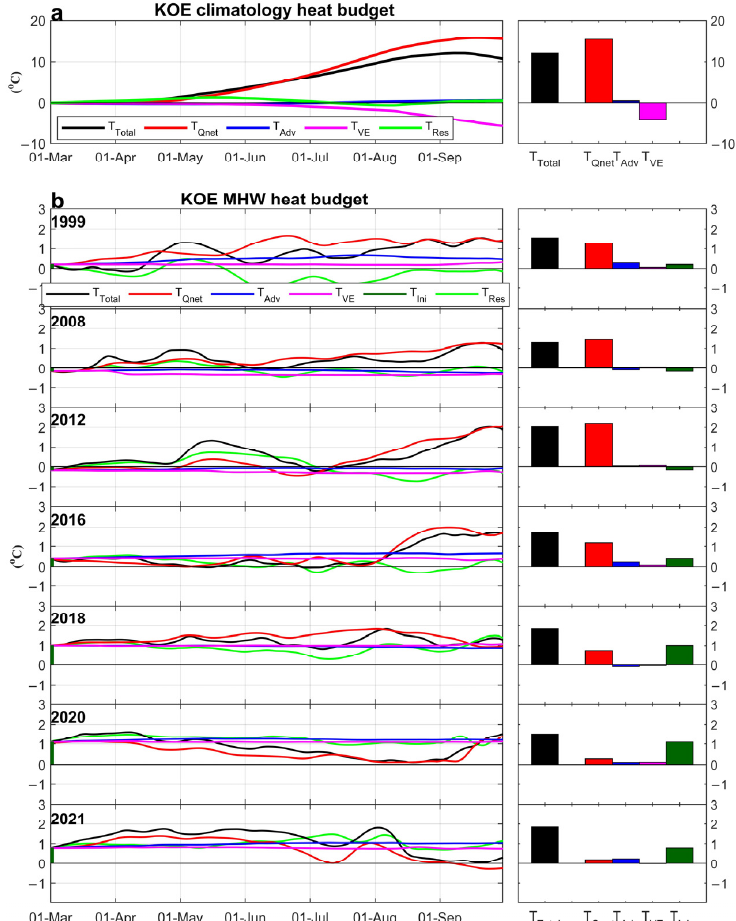
Figure 5. ( a ) Climatology ML temperature budget and the contributions from air-sea heat flux (red line), horizontal advection (blue line), vertical entrainment (magenta line), and residual (green line) in the KOE region. ( b ) same as ( a ), but for the ML temperature anomaly budget of the individual MHW years. Contributions from different terms to the temperature change from March to the JA peak values are shown in the right panels. Initial value contributions are denoted with dark green bars. The units of the right panels are the same as the left panels.